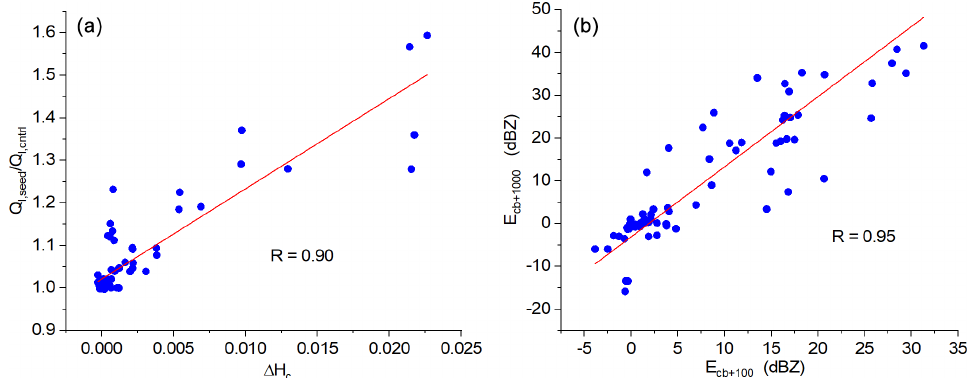
Figure 8. (a) The impact of the change of the H c parameter on the vapor uptake. The vertical coordinate represents the ratio of liquid water contents belonging to the seeded and associated control cases. (b) This panel shows how the broader size distribution generated by the Ostwald-ripening effect close to the cloud base ( E cb + 100 ) can result in broadening of the size distribution comparing to the control case 1000m above the cloud base ( E cb + 1000 ) . E cb + 100 and E cb + 1000 mean the calculated change of reflectivity due to seeding (Eq. 4) at 100 and 1000m above the cloud base, respectively.